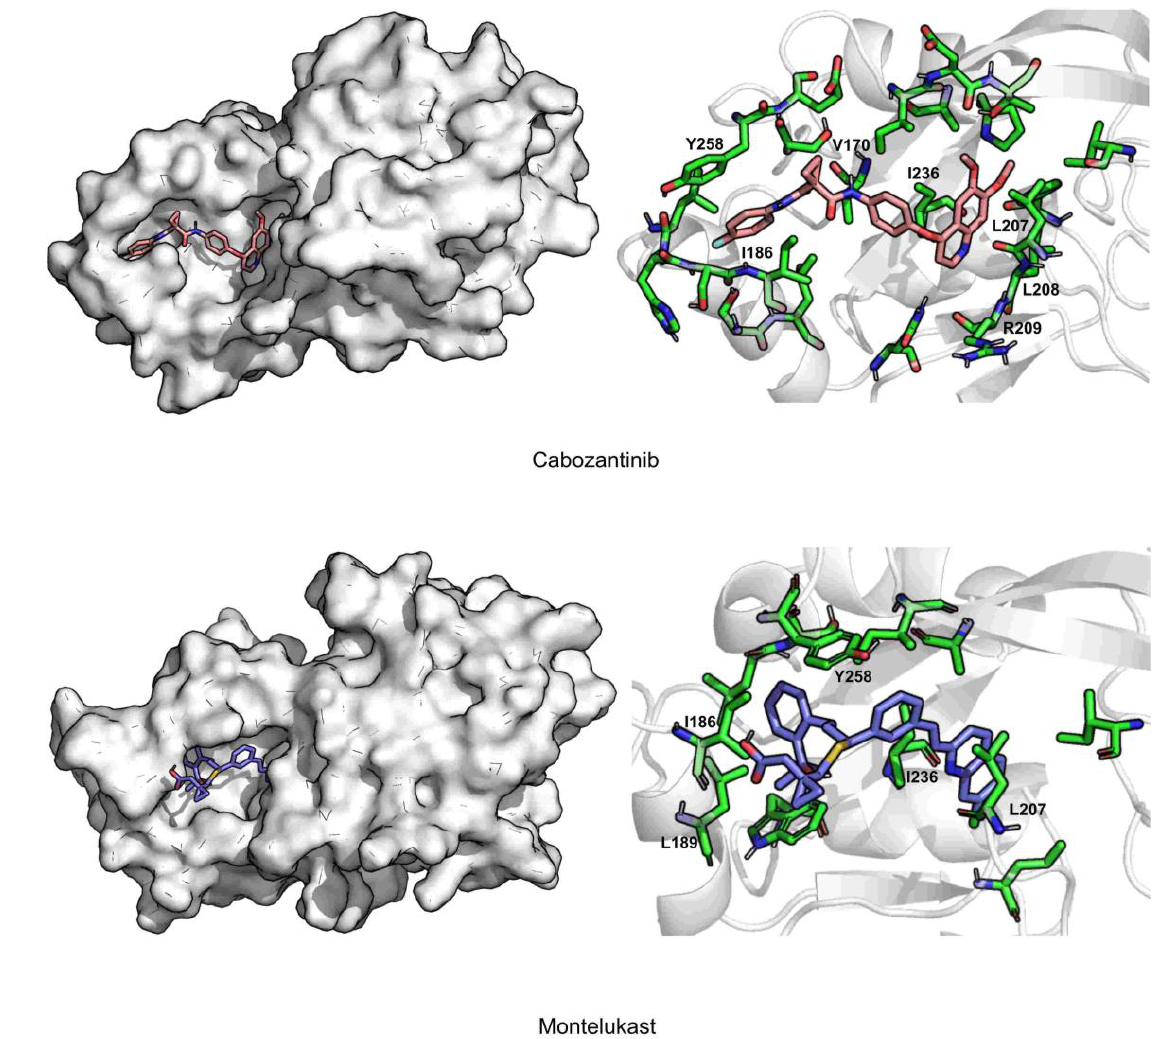
Figure 8. Interaction maps of cabozantinib and montelukast.